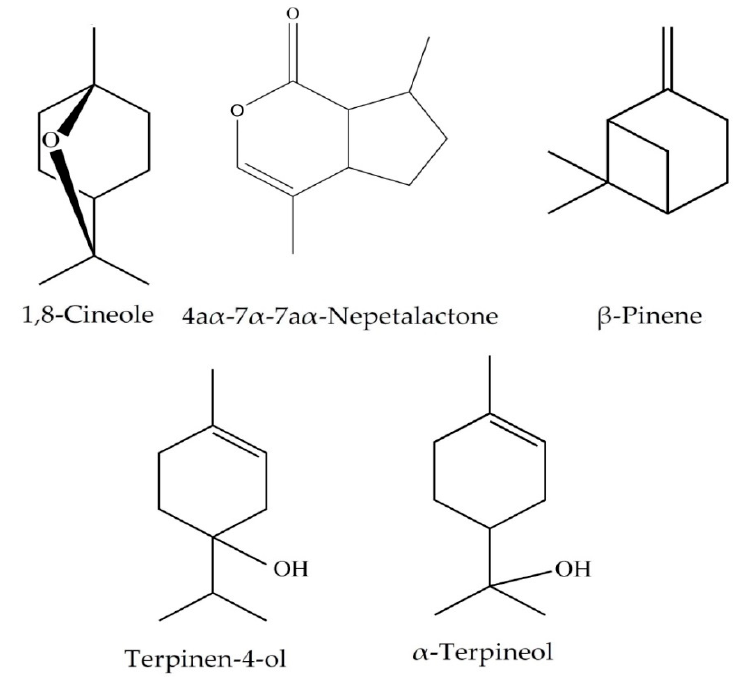
Figure 1. Chemical structure of the major compounds of the Nepeta juncea extracts.